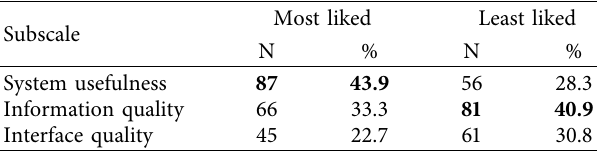
Table 4: Descriptive statistics for the most and least liked about electronic patient care report system software. Subscale